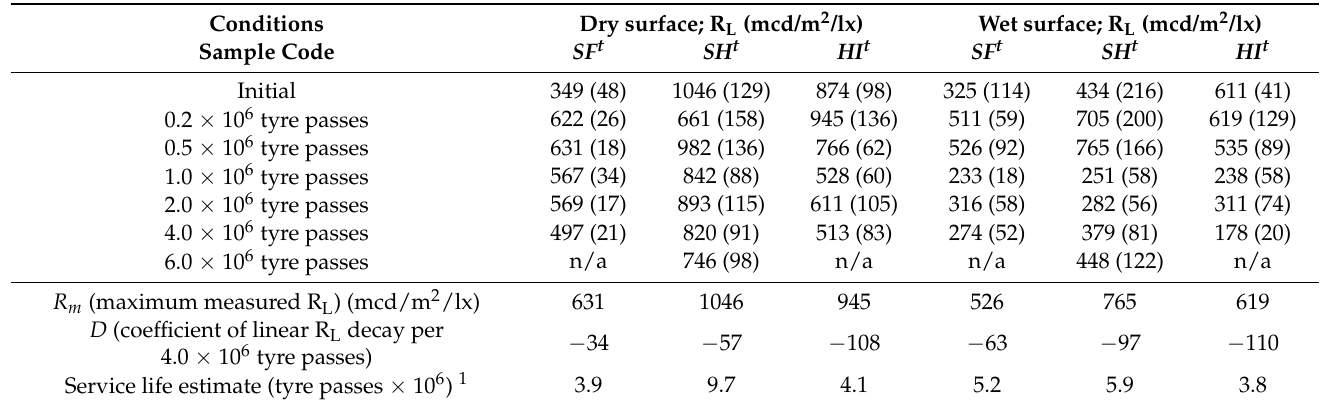
Table 5. Turntable test: loss of R L and service life parameters calculated per Equation (2).